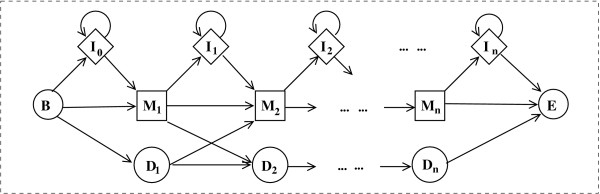
A profile hidden Markov model as introduced by Krogh et al. [1]. Squares indicate match states (Mi), diamonds insert states (Ii) and circles delete states (Di). Possible transitions are shown as arrows. Begin state (B), End state (E) and delete states (Di) are silent states, i.e. they do not emit symbols of the alphabet.